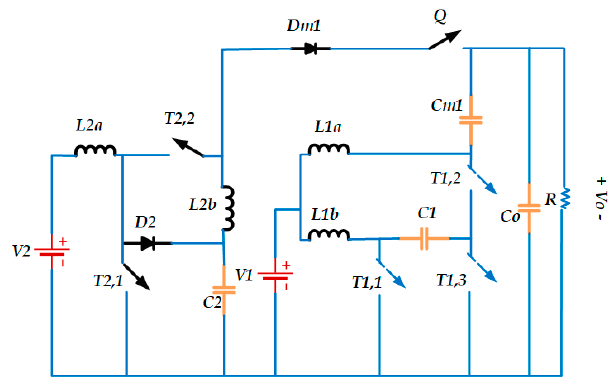
Figure 12. Dual Input Topology.